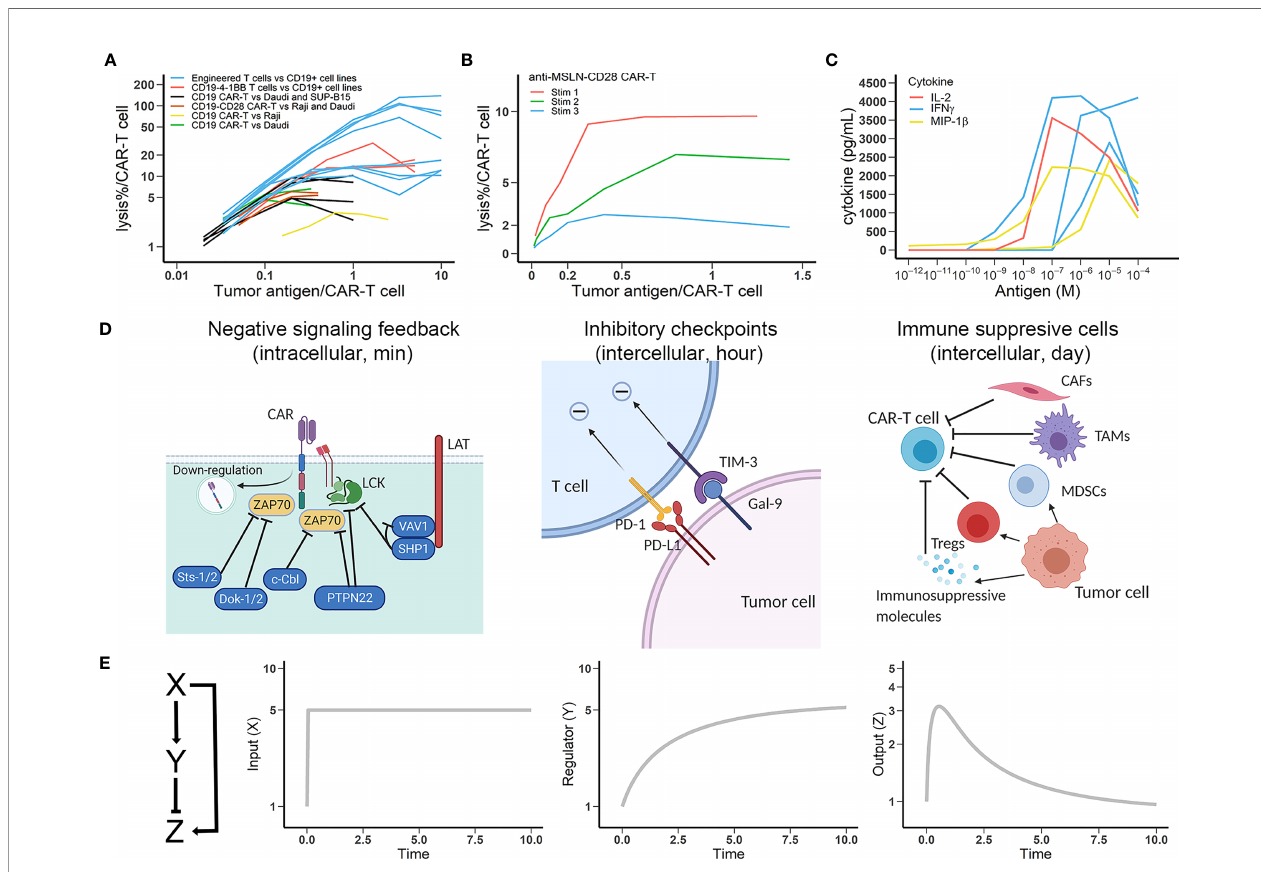
FIGURE 1 | Multiple negative regulatory mechanisms that account for CAR-T cell exhaustion are captured by the incoherent feedforward loop (IFFL). (A) CAR-T cell lytic capacity (percentage of tumor cells lysed) at increasing densities of tumor antigens. Data are from multiple anti-CD19 CAR products. Data source: blue lines, engineered umbilical cord blood (UCB) T cells speci fi cally killing CD19+ cell lines (19); red lines, cytotoxicity of CD19-4-1BB z UCB T cells against Daudi, HPB, and K562-FCD19 cells (20); black lines, killing of Daudi and SUP-B15 cells by CD19 z and CD19-CD28 z CAR-T cells (21); brown lines, lytic activity of CD19-CD28 z CAR against Raji and Daudi cells (22); yellow line, CAR-T cell cytotoxic activity against Raji cells (23); green lines, CD19 z and CD19 z -CD28 CAR-T cells lysed Daudi cells (24). Lines in the same color differ in the experimental conditions. (B) Lytic capacity (percentage of tumor cells lysed) of anti-MSLN-CD28-CAR-T upon repeated antigenic stimulation (25). (C) The secretion capacity of potent effector cytokines by CAR-T cells at varying antigen densities for 24 hrs (26). (D) Schematic view of negative regulatory mechanisms in CAR- T cell function. Left, negative feedbacks in intracellular CAR activation signaling; Middle, representative modes of intercellular inhibition by checkpoint molecules; Right, representative modes of intercellular inhibition mediated by tumor-resident cells, which can secrete soluble immunosuppressive molecules and express membrane-bound inhibitory molecules. (E) The IFFL with dynamic pro fi les of input, regulator, and output (27). The y-axe in fi gures is the fold-change from baselines (assumed to 1). Time is in arbitrary units in all plots. Using typical T cell regulation rate, the response time is in the range of minutes to